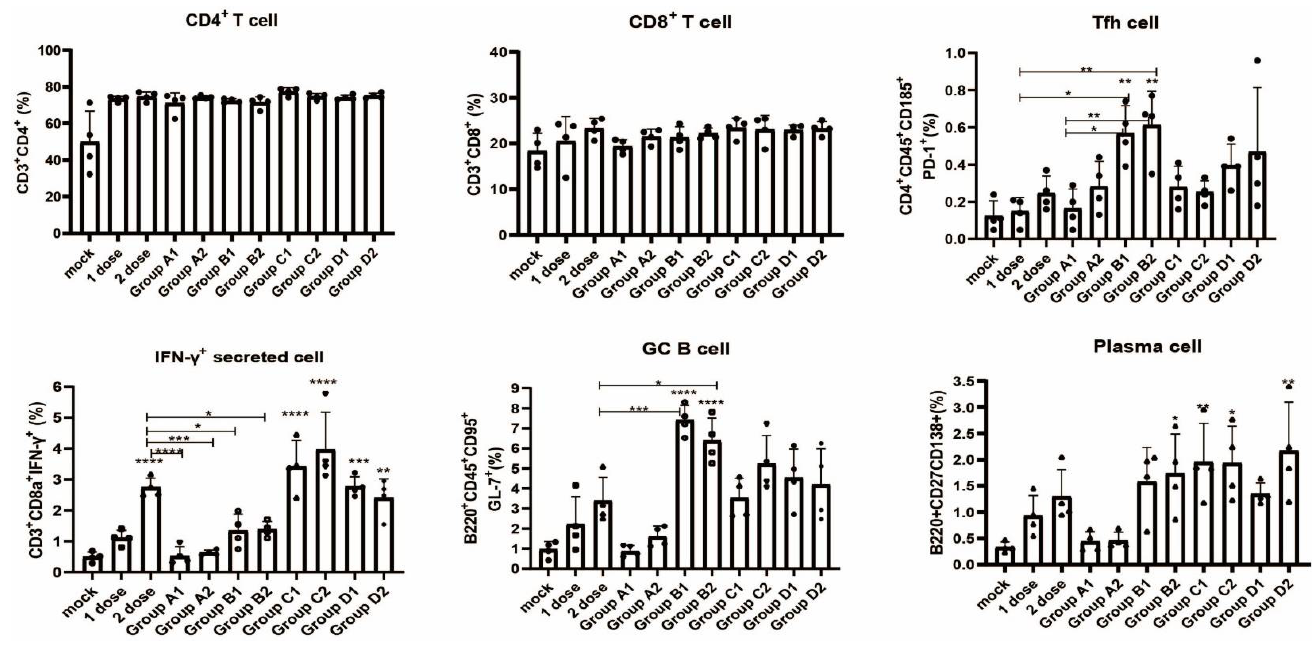
Figure 5. Different vaccination groups elicited immune cell population percentage changes in CD4+ T cells, CD8+ T cells, Tfh cells, GC B cells, plasma cells and IFN-γ-secreting cells in local lymph nodes. For cell data detected as 0% in flow cytometry, we assigned a value of 0.05% for plotting. 1 dose: 1 dose inactivated vaccine control group; 2 dose: 2 doses inactivated vaccine control group; one-way ANOVA (and nonparametric or mixed) was conducted; * p < 0.05; ** p < 0.01; *** p < 0.001; **** p < 0.0001 versus the control group.